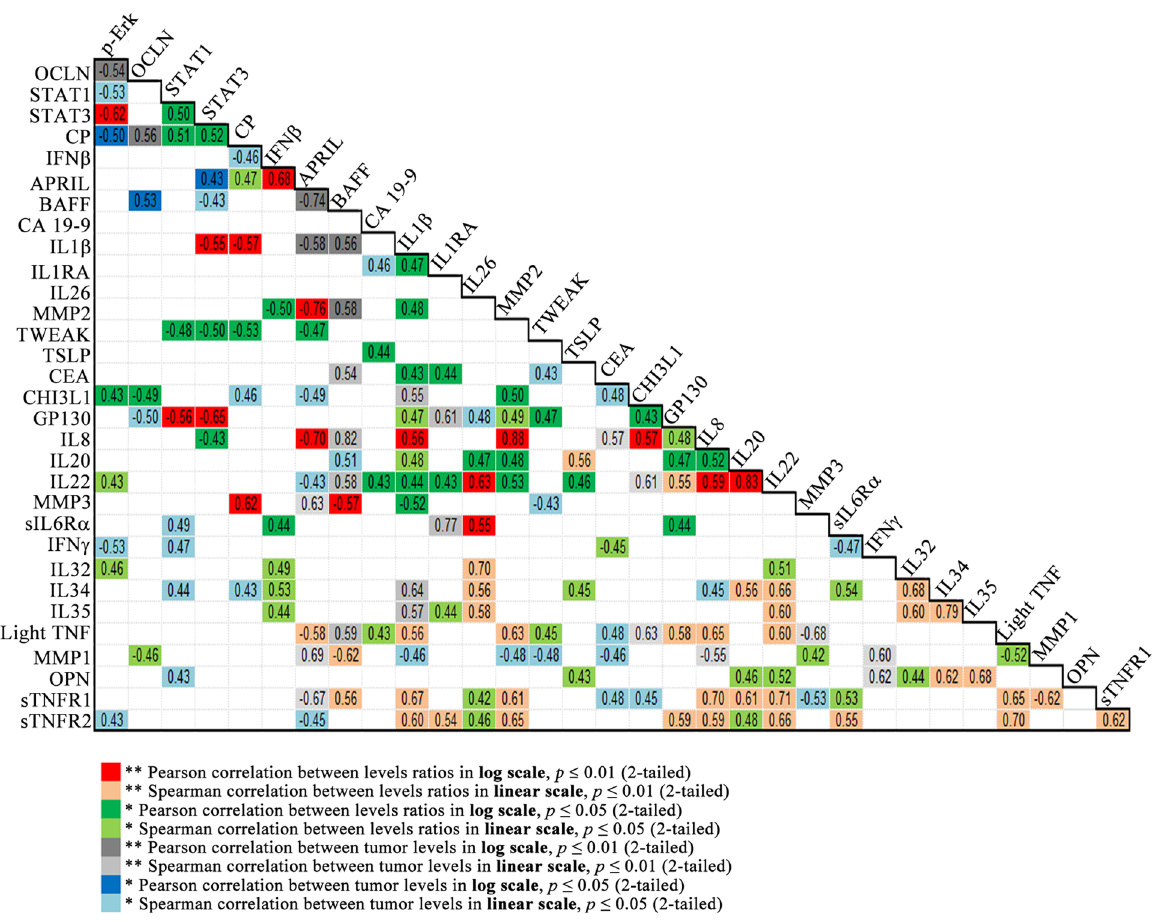
Figure 3. Combined multi-type variables correlation matrix containing the highest values of the correlation coefficients. Combinations of the two levels of significance (0.01 and 0.05) and the type of correlation (Pearson or Spearman) is color-coded, as shown in the legend below the